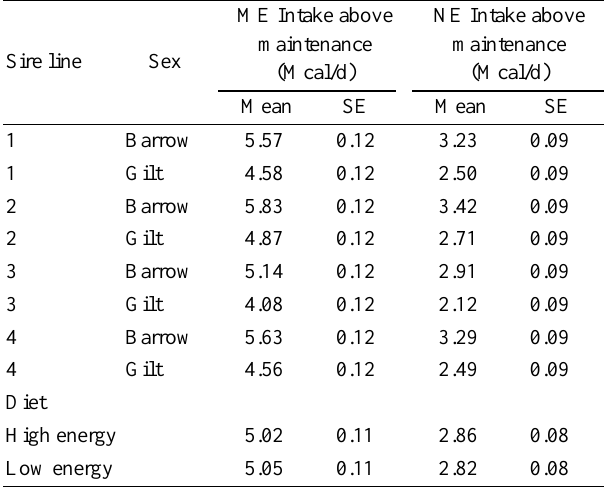
Table 11. Sire line by sex and diet least-squares means for daily feed intake, daily ME intake and daily ME intake above